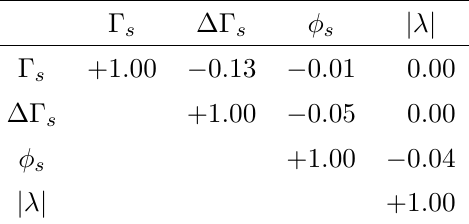
Table 8 . The correlation matrix taking into account both statistical and systematic uncertainties for the combination of the three measurements B 0